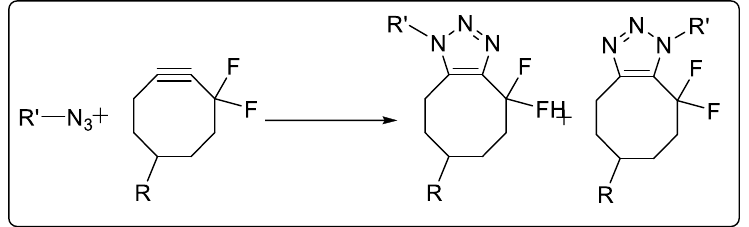
Figure 5. Strain-promoted [3 + 2] cycloaddition of azides and cyclooctynes.